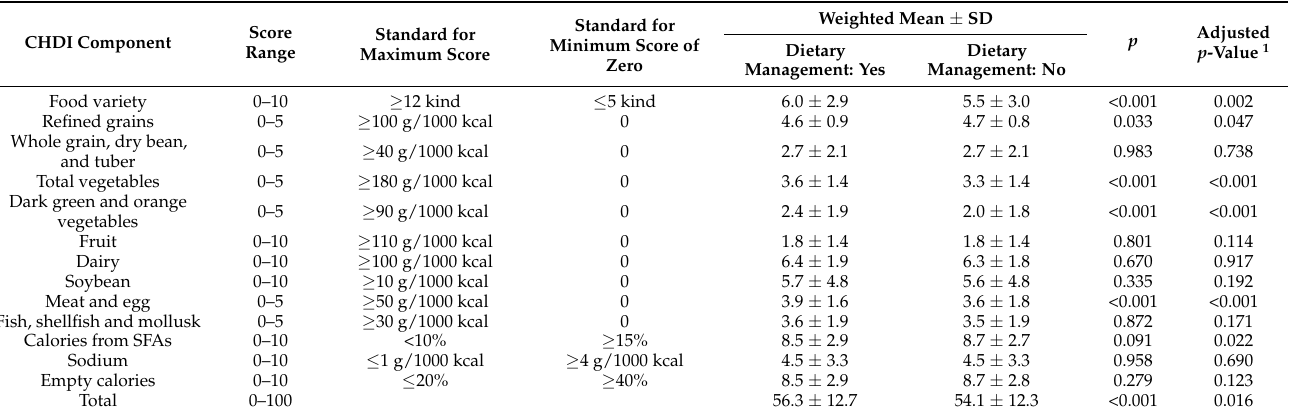
Table 3. CHDI components and criteria for scoring and the score of adults with diabetes in the three rounds of China National Nutrition